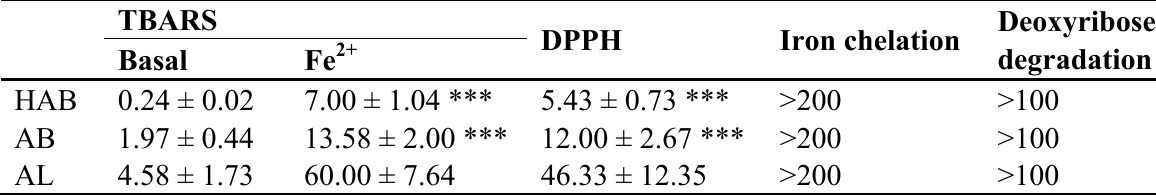
values (µg/mL) for TBARS, DPPH, iron chelation and deoxyribose Table 2. IC 50 degradation by hydroalcoholic bark (HAB), aqueous bark (AB), and aqueous leaves (AL) extracts from S. rotundifolium